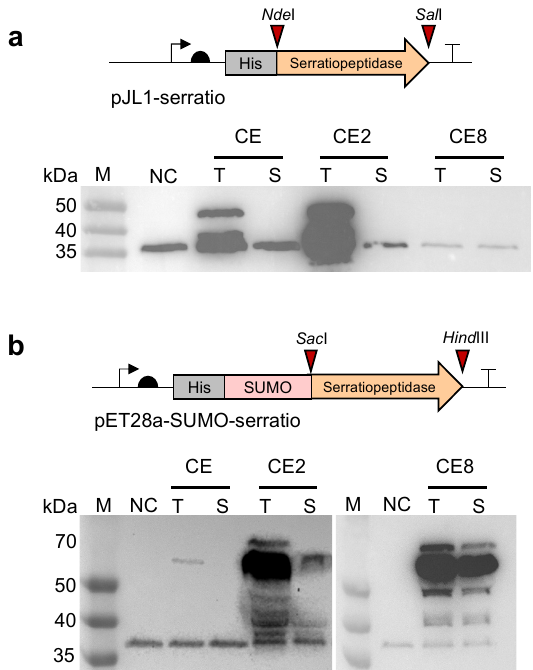
Figure 2. Optimization of the CFPS system for soluble expression of serratiopeptidase. ( a ) Western-blot analysis of cell-free expressed serratiopeptidase (50 kDa) using different cell extracts. The plasmid of pJL1-serratio with an N-terminal 6x His tag was used for CFPS reactions. ( b ) Western-blot analysis of cell-free expressed SUMO-serratiopeptidase (61 kDa) using different cell extracts. The plasmid of pET28a-SUMO-serratio with an N-terminal 6x His tag was used for CFPS reactions. In ( a , b ), CE: cell extracts prepared from E. coli BL21 Star (DE3); CE2: CE enriched with the chaperones of GroES-GroEL-tig; CE8: CE enriched with the chaperones of DnaK-DnaJ-GrpE and GroES-GroEL; NC: negative control without plasmid in the CFPS reaction; T: total protein; S: soluble protein; M: protein molecular weight marker. The protein band between 35 and 40 kDa was an unknown protein derived from the cell lysate.